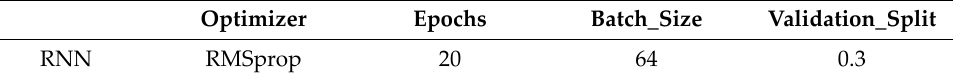
Table 3. Settings of RNN